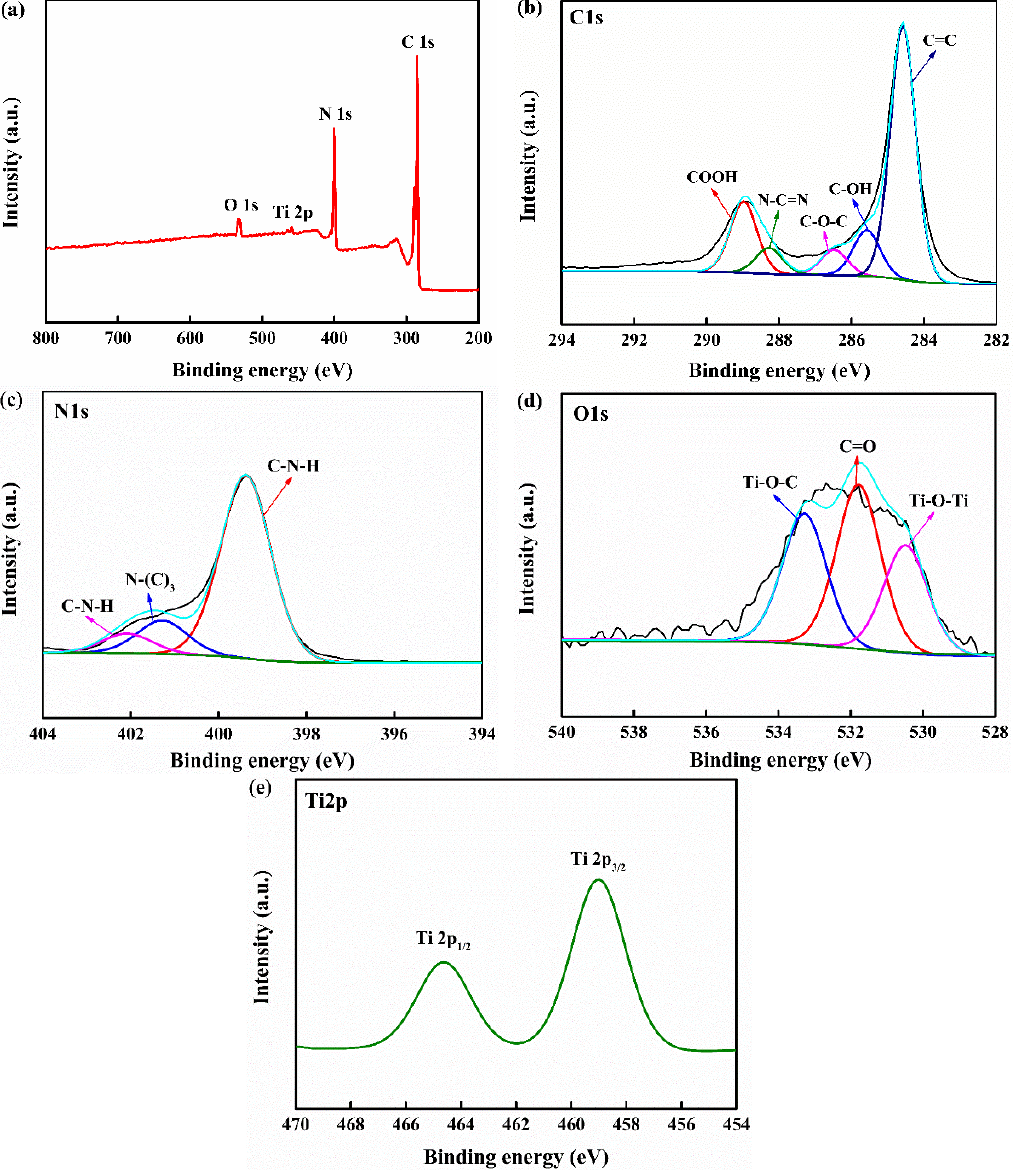
Figure 3. ( a ) XPS survey spectrum of CNTC-20; ( b ) C1s high-resolution XPS spectrum of CNTC-20; ( c ) N1s high-resolution XPS spectrum of CNTC-20; ( d ) O1s high-resolution XPS spectrum of CNTC-20; ( e ) Ti2p high-resolution XPS spectrum of CNTC-20.